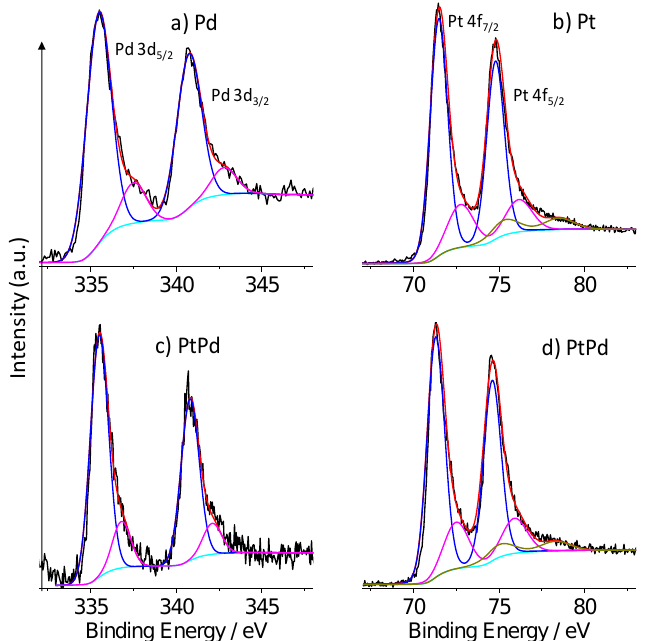
Figure 5. Al-K α excited photoelectron spectra of Pd 3d binding energy region of: ( a ) Pd-GP and ( c ) Pt 80 Pd 20 -GP. The 3d 5/2 — 3d 3/2 spin-orbit doublets (blue and magenta line) refer to the Pd 0 and Pd(II) states, respectively; 4f binding energy region of: ( b ) Pt-GP and ( d ) Pt 80 Pd 20 -GP. The 4f 7/2 —4f 5/2 spin-orbit doublets (blue, magenta and dark yellow line) refer to Pt 0 , Pt(II) and Pt(IV) states, respectively. The cyan line refers to the background and the red line superimposed to the experimental black profile refers to the sum of all of the Gaussian components.